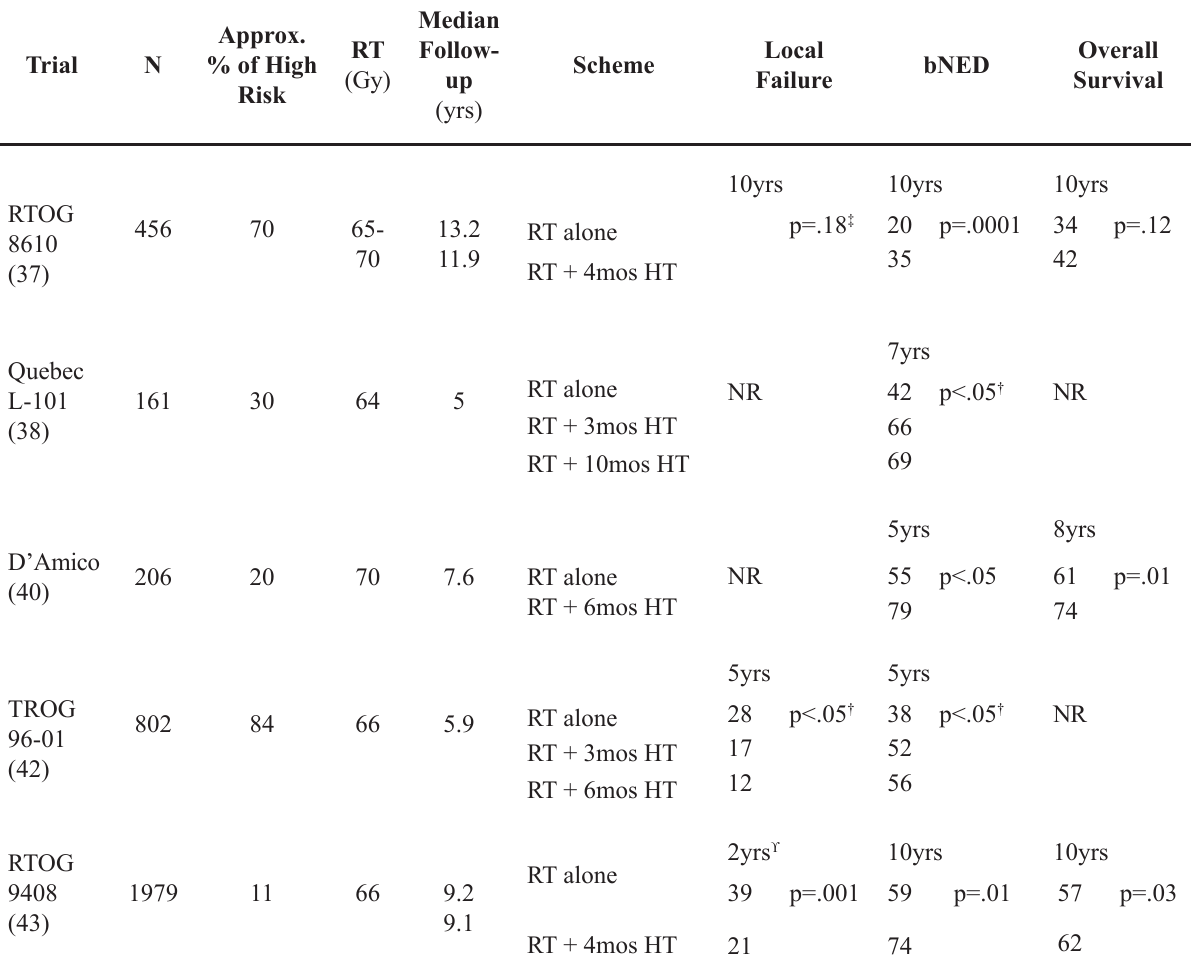
Table 1 – Completed phase III trials of neoadjuvant androgen deprivation therapy.